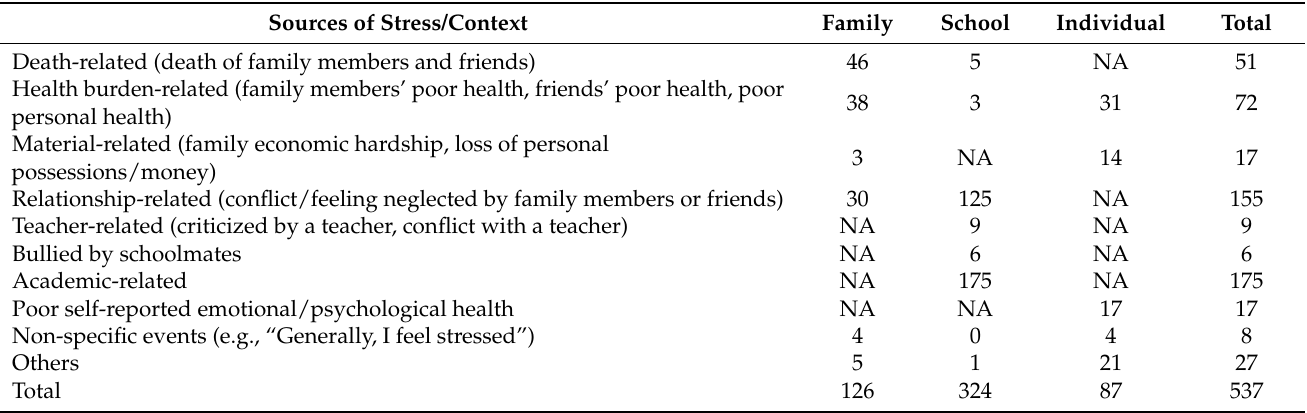
Table 2. Sources of stress identified by participants in